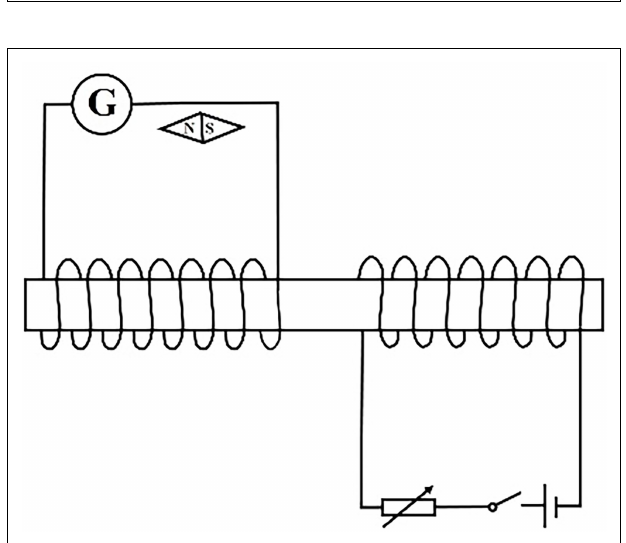
Table 2 : To enable students to judge the change of magnetic flux in a closed loop in a physical situation, so as to judge the direction of the induced current.